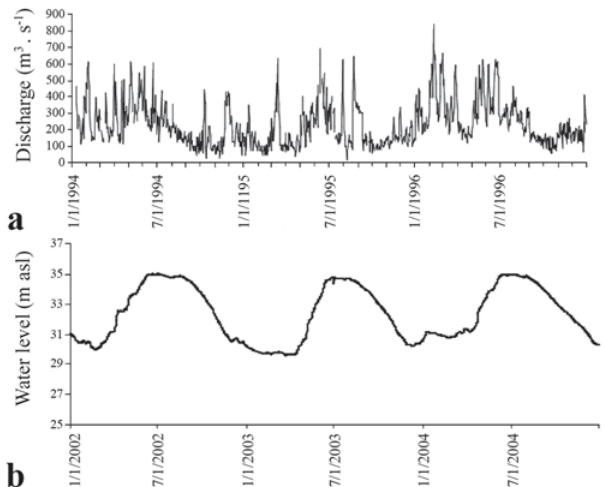
Fig. 2. (a) Daily variations of discharge at the entrance of Petit-Saut reservoir from January 1994 to December 1996. (b) Daily variations of water level in Petit-Saut Reservoir from January 2002 to December 2004. (asl = above sea